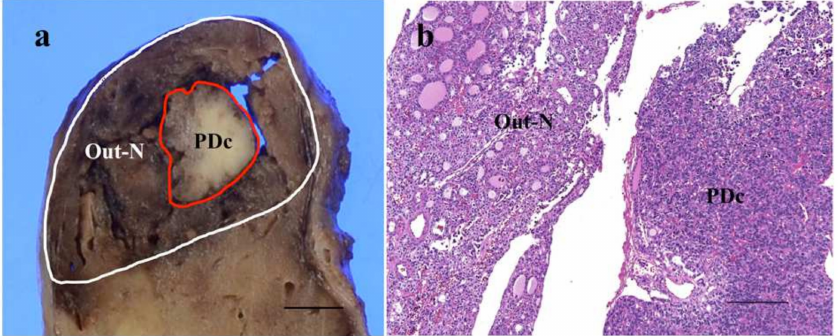
Figure 1. Representative image of cut-surface of thyroid follicular-patterned tumor showing nodule-in-nodule appearance with poorly differentiated component (PDc) ( a ). A histological feature of the border area between outer nodule (Out-N) and PDc at low power magnification ( b ). The scale bars indicate 5 mm in ( a ) and 200 µ m in ( b ).